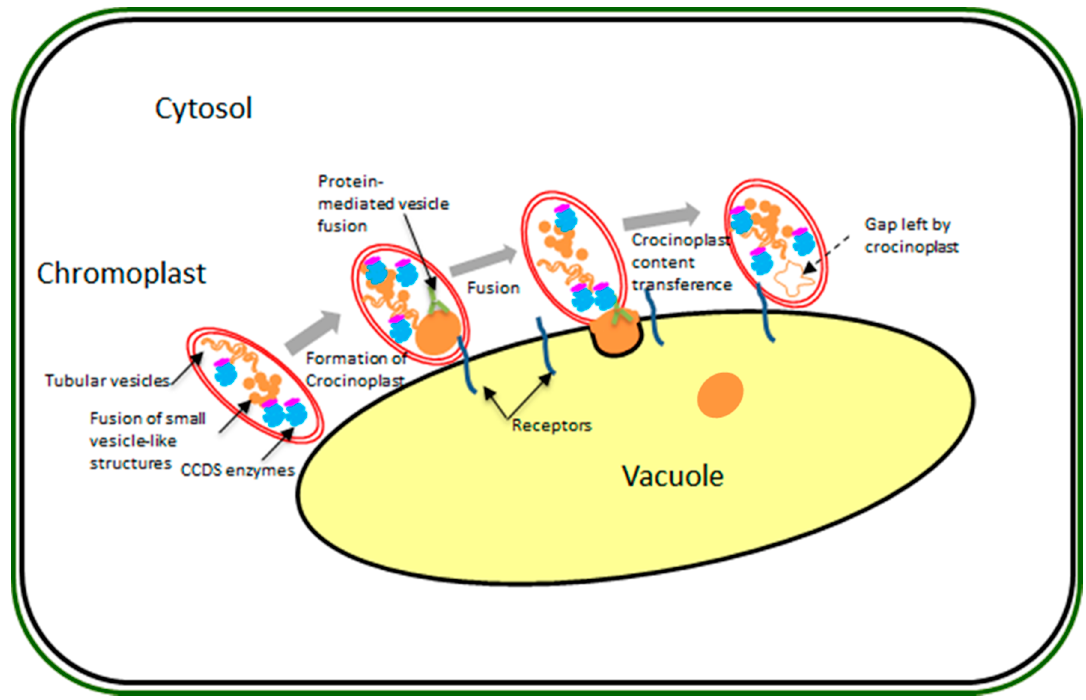
Figure 8. Proposed model of crocin transport from chromoplast to the vacuole.